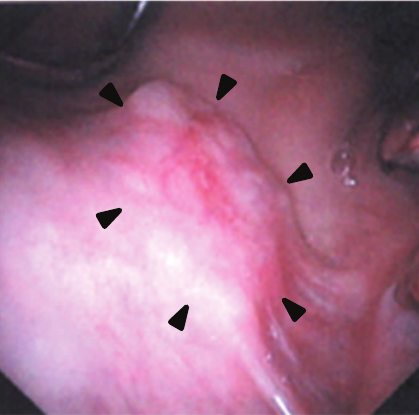
Figure 1: Local findings. A smooth, elastic hard, and exophytic mass was detected in the right buccal mucosa. Its surface was not erosive or ulcerated. Two tooth crowns can be seen on the right side of this